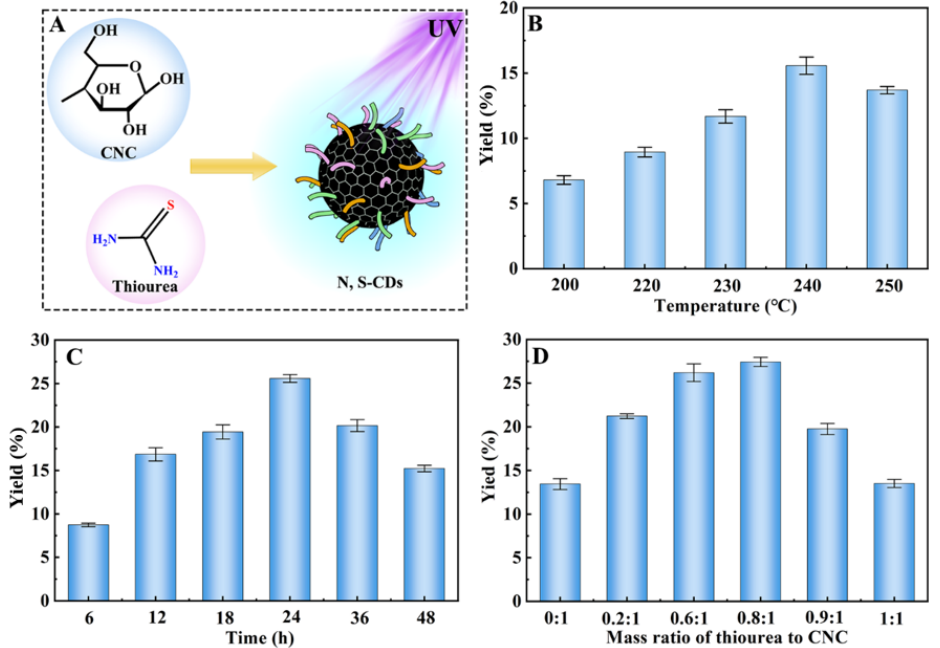
Figure 1. The illustration of the hydrothermal process for preparing N, S-CDs ( A ), the effect of reaction temperatures ( B ), reaction times ( C ), and the mass ratio of thiourea to CNC ( D ) on the QYs of N, S-CDs.